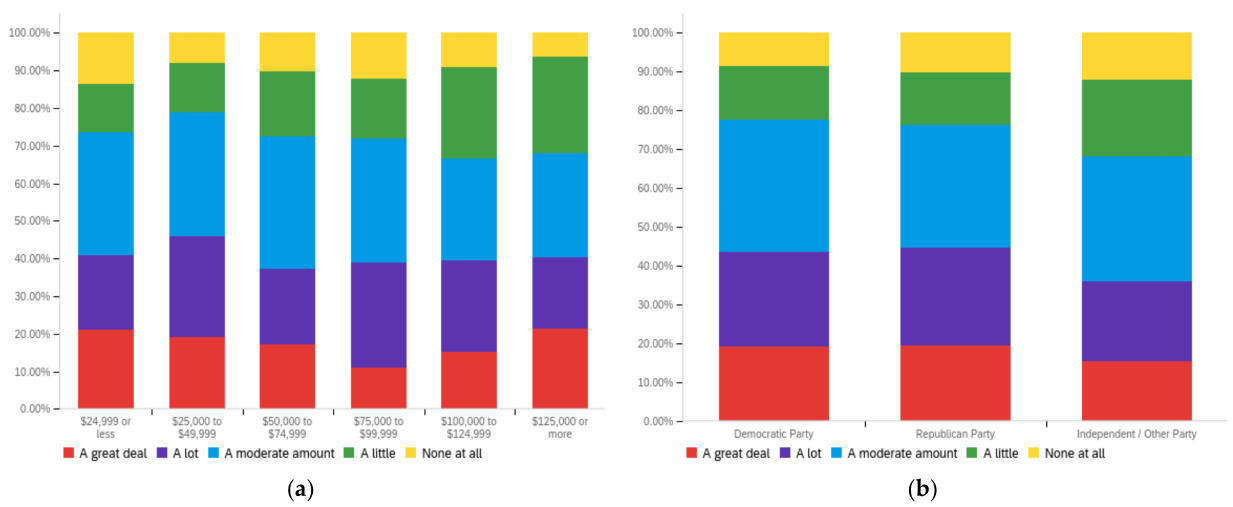
Figure A35. Cont